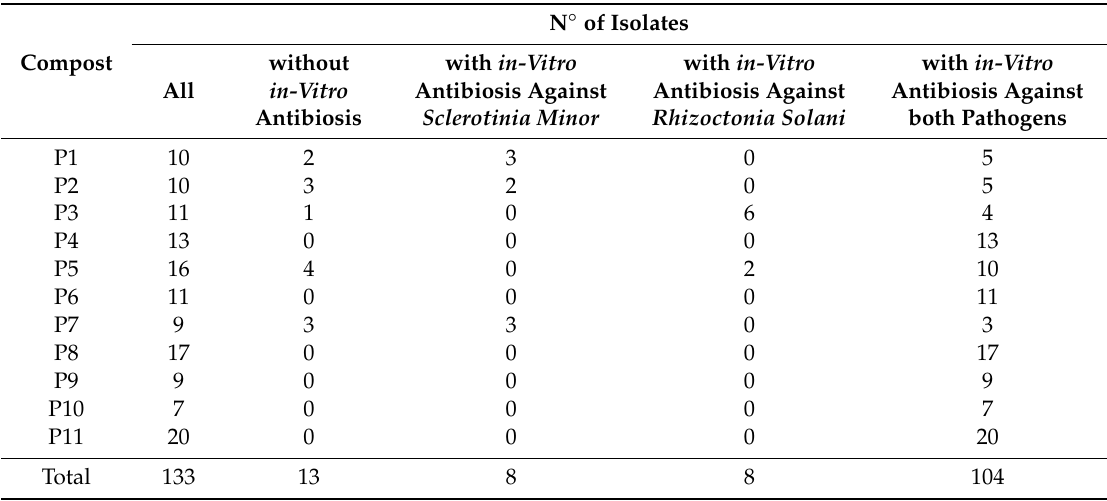
Table 2. General report on the in vitro antagonistic activity of the isolated bacterial colonies from